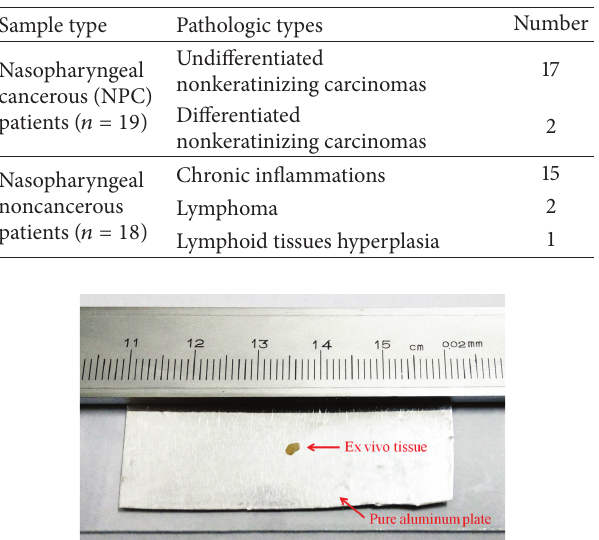
Figure 1: Nasopharyngeal ex vivo tissue placed on the pure alu- minum plate. Pure aluminum and sample are pointed out by the black arrow.